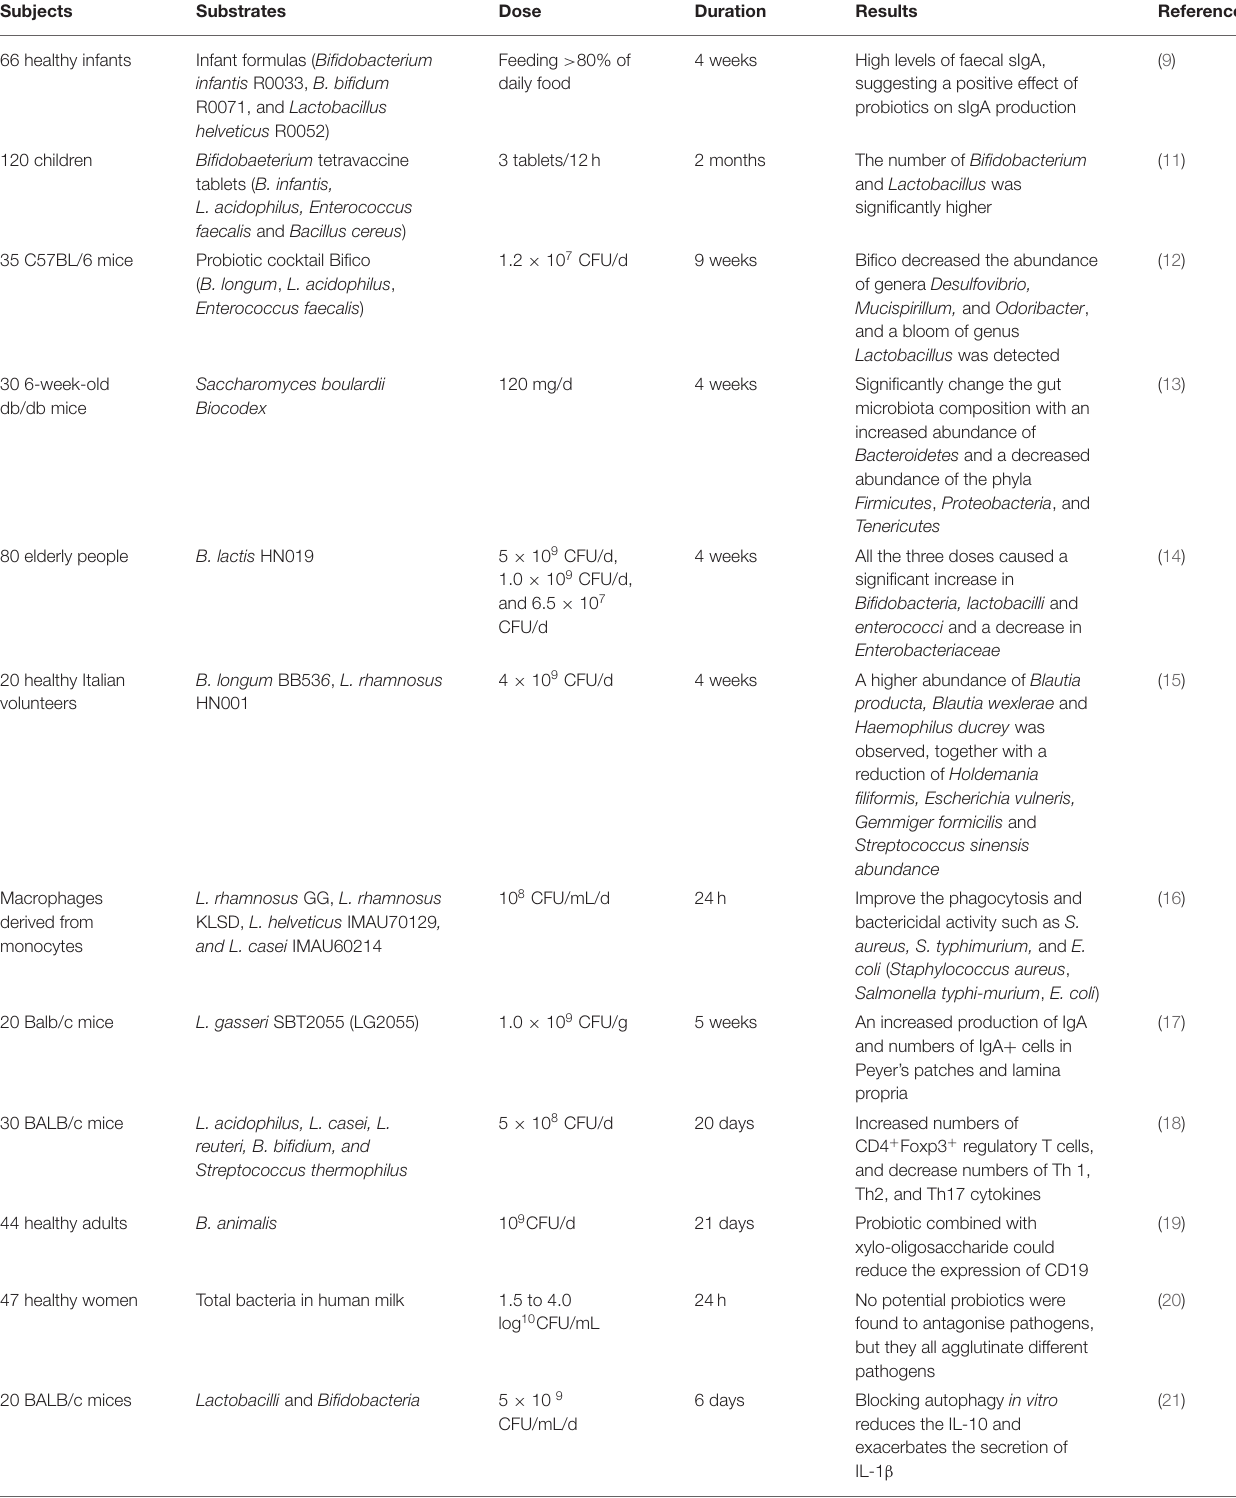
TABLE 1 | Example of studies designed to determine effects of probiotics on gut microbiota and immune function.